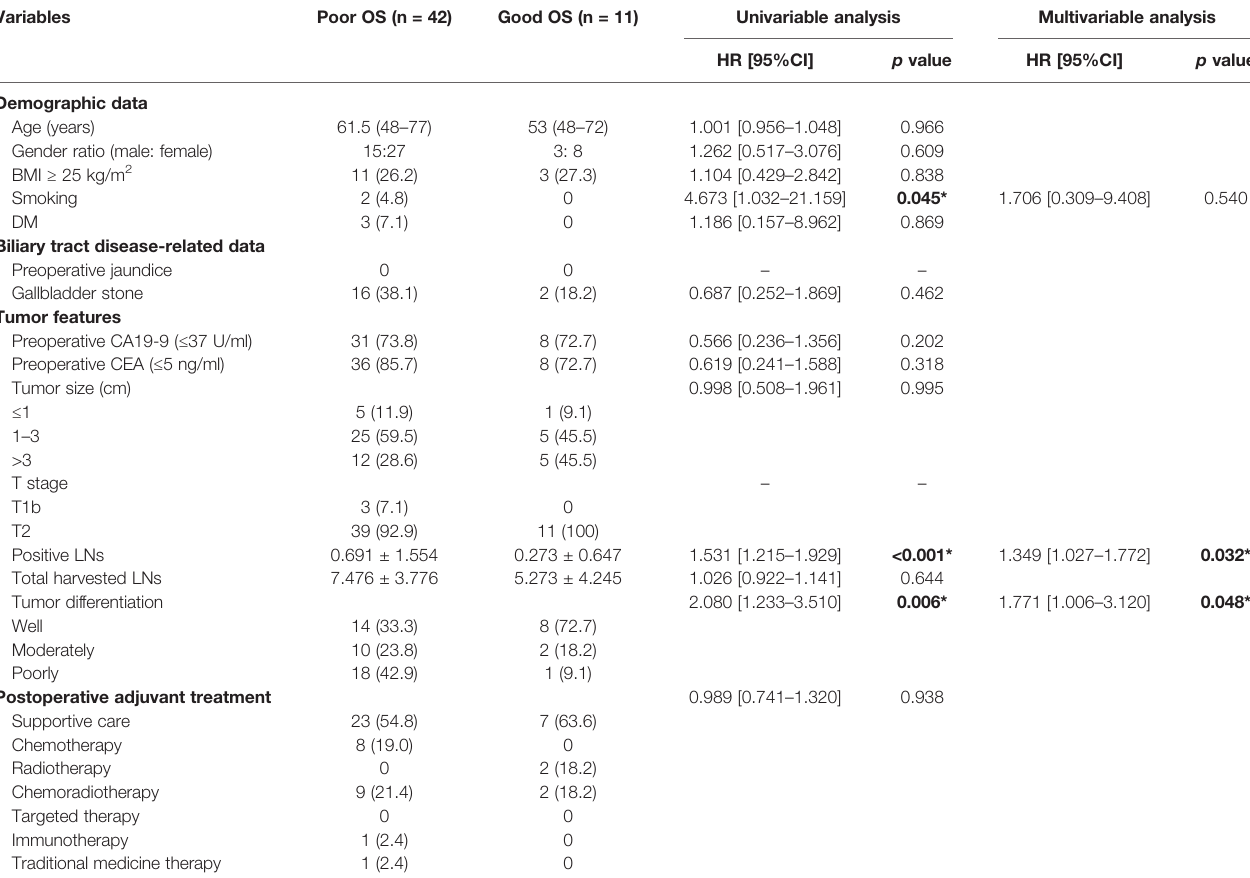
TABLE 2 | Potential risk factors for OS in GBC patients undergoing PLA based on univariable and multivariable analyses.